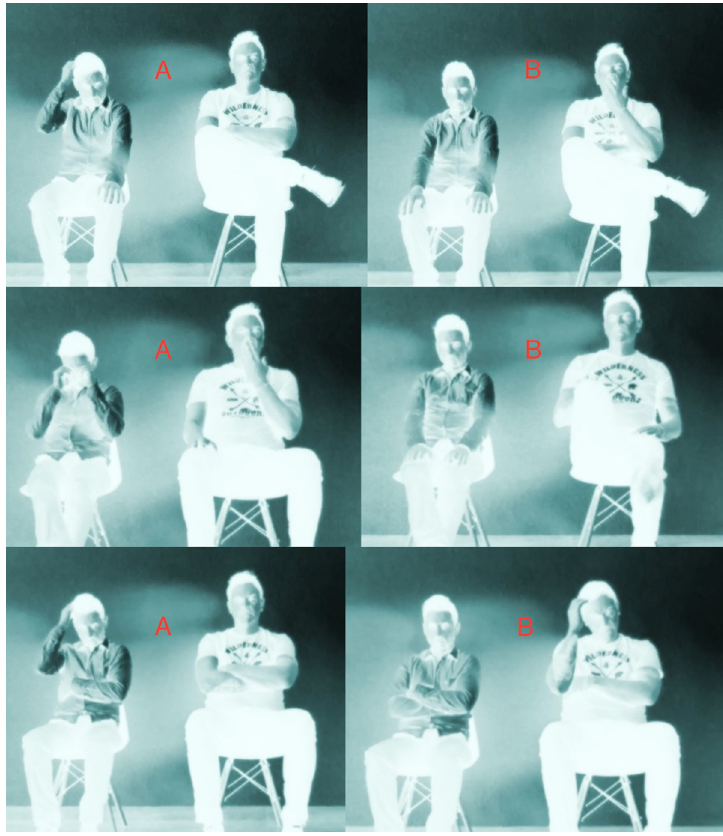
Fig 1. Screenshots of typical sequences (A-B) from the three conditions (dark filter largely removed for better image clarity—see SOM for original videos). Top: No Contingency condition. Sitting in different positions, actor 1 scratches his head while actor 2 remains still (A). Eleven seconds later actor 2 starts to yawn, while actor 1 retains his previous position (B). Middle: Temporal Contingency condition. Sitting in different positions, actor 1 gently rubs his eyes while actor 2 yawns simultaneously (A). Twenty seconds later, actor 2 starts crossing his legs, and actor 1 simultaneously starts tapping his fingers on his knees (B). Bottom: Form Contingency condition. Sharing the same overall position, actor 1 scratches his head with his right hand while actor 2 remains still (A). Four seconds later, actor 2 scratches his head with his right hand while actor 1 remains still (B).